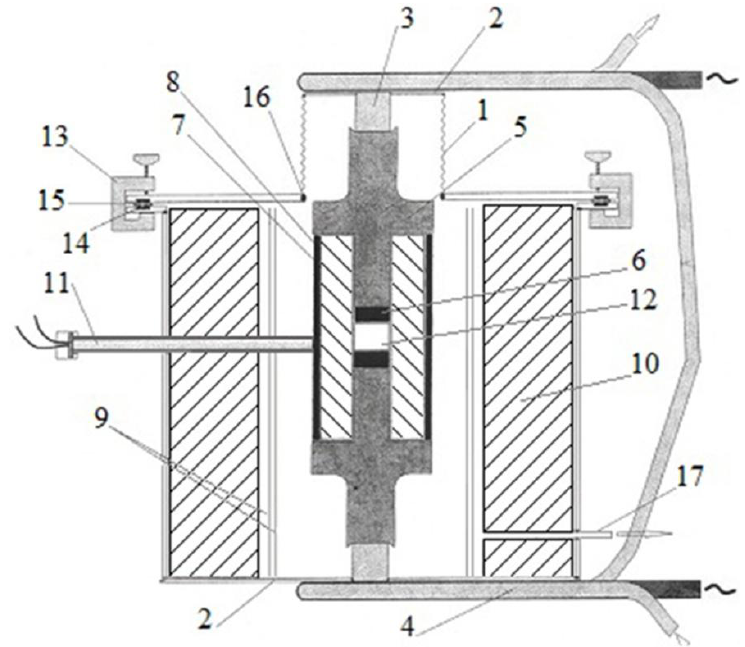
Figure 17. Schematic of the hot-pressing facility using direct passage of alternating current of industrial frequency through the powder to be consolidated manufactured by Research and